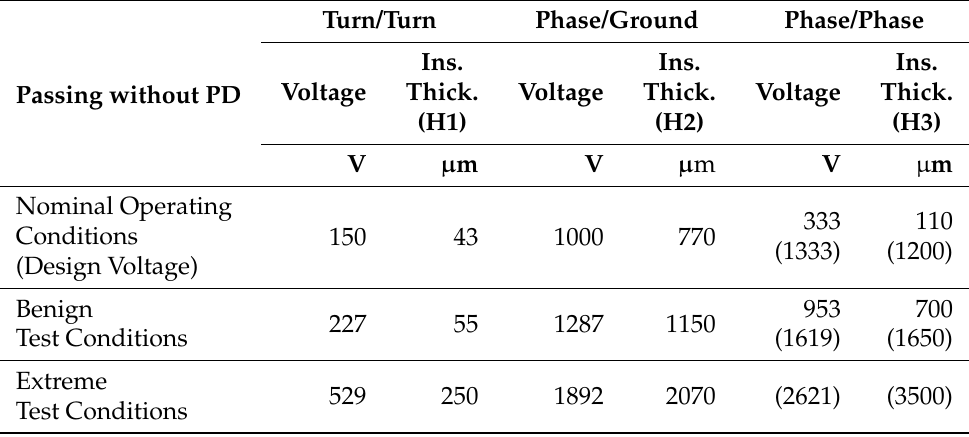
Table 1. Test voltages for the three insulation sub-systems (see Section 3) and minimum insulation thickness where PD likelihood is estimated as negligible (Equation (3)) for benign and extreme test condition (based on IVIC concept in [3]). Sinusoidal or impulse voltage, same modulation frequency. Values between brackets correspond to a worst case of phase-to-phase